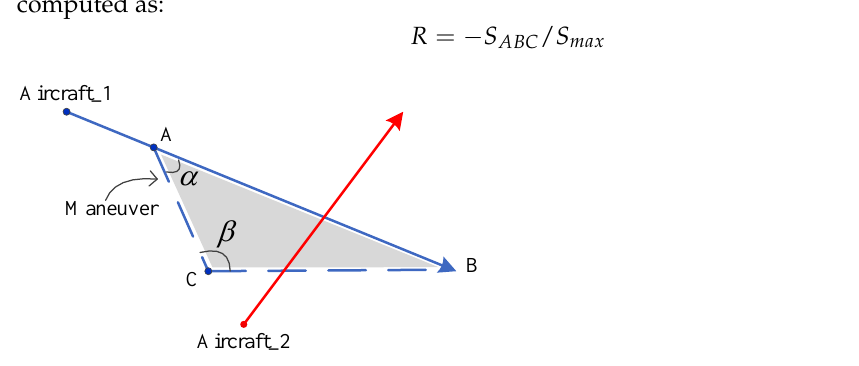
Figure 7. Deviation of the resolution from original